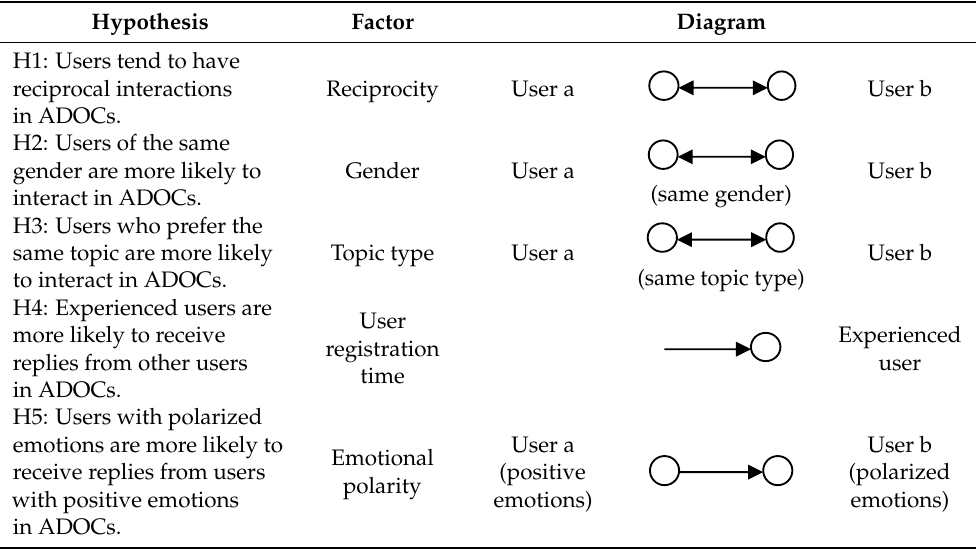
Table 2. Research hypothesis and network structure diagram. Hypothesis Factor Diagram